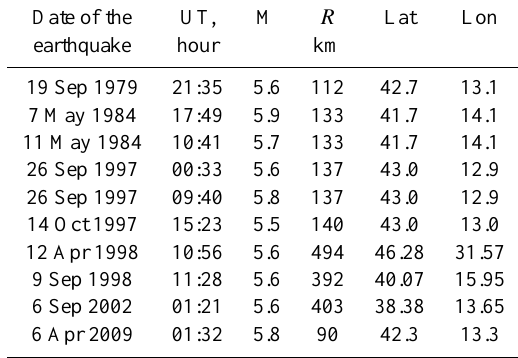
Table 1. The earthquakes with magnitude M ≥ 5.5 registered in Italy during 1979–2009. Geographical coordinates of the earthquake epi- centers and the distance ( R ) from the Rome ionosonde are